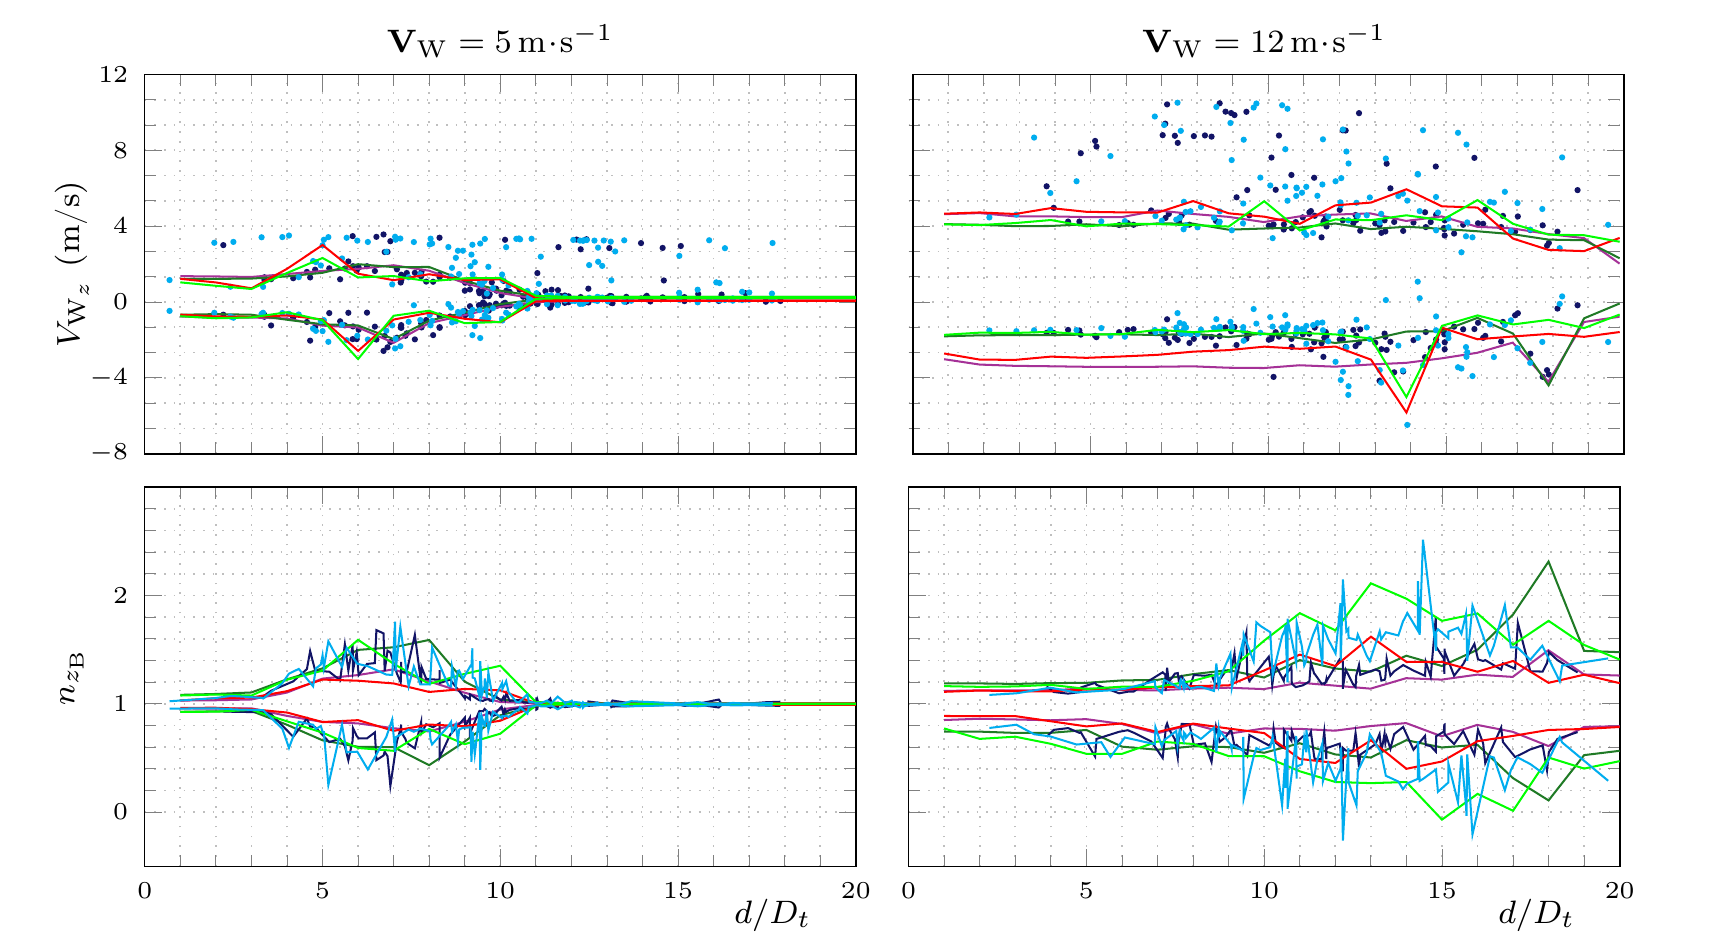
Figure 9. Maximum and minimum values of the wind velocity components along the aircraft z B axis and the consequently arisen normal load factor n z a function of the normalized distance from the turbine rotor along the wind axis. Wrap of the deterministic Sets 1, 2 and the random Set 3 for all ALM cases. Legend for all diagrams: (cid:4) 50kn in-axis; (cid:4) 100kn in-axis; (cid:4) 50kn off-axis; (cid:4) 100kn off-axis; (cid:4) Sets 3 in-axis; (cid:4) Sets 3